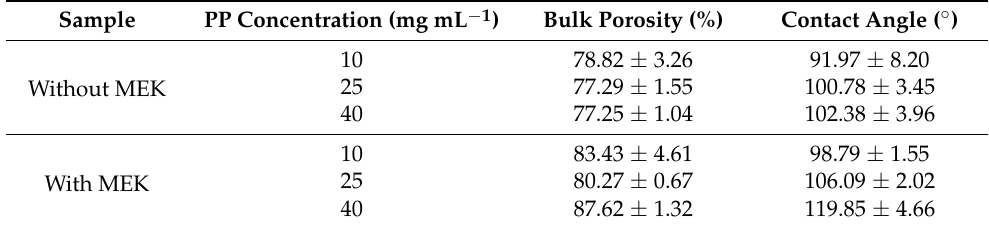
Table 4. Summarized bulk porosity values and contact angles for all PP concentrations with and without